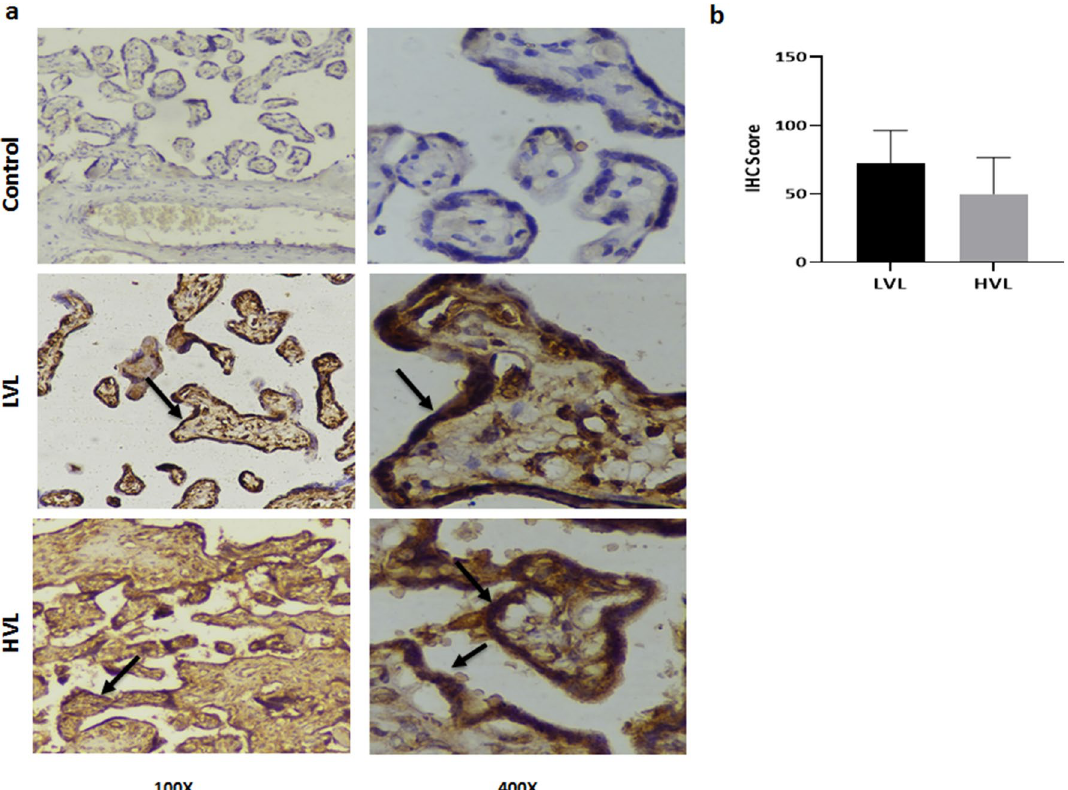
Figure 3. Presence of HBeAg in placenta. ( a ) Representative image showing the presence of HBeAg in placenta by Immunohistochemistry, no staining in control and strong cytoplasmic staining in LVL and HVL groups was observed. ( b ) IHC Scores of HVL and LVL groups showed no significant difference (HVL 50 ± 8.43 vs. LVL 72.5 ± 7.51 p = 0.2204; * < 0.05). Two-tailed p-value was calculated for a risk threshold α = 0.05. p* < 0.05. HVL High Viral Load Group, LVL Low Viral Load